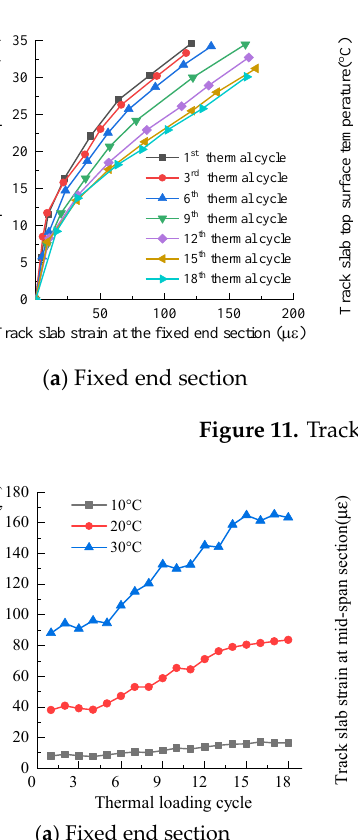
Thermal loading cycles Figure 10. Curve of the gap length varying with the cycles of temperature loading action. During the 18th thermal loading cycle, the gap only appears in the track slab near the fixed end with the shear slot along the longitudinal direction of the bridge. There is no gap at the sliding end of the beam far away from the shear slots. This shows that the restraint of the shear slots on the free deformation of the track structure is one of the important causes of the interlayer gap initiation under the action of thermal loading. Due to the influence of construction technology, the bond strength of the interlayer interface between the CA mortar and the track bed is far greater than that of the interlayer interface between the CA mortar and the track slab. Therefore, the interface gap mainly occurs between the CA mortar and the track slab. The interface between the CA mortar and the track bed remains intact, and no gap was observed. 3.3. Strain Results under Thermal Load 3.3.1. Track Slab Strain From the processing of the data collected by the fiber grating strain gauges, the variation law of the track slab temperature–strain curve with the number of thermal loading cycle was obtained, as shown in Figure 11. It can be seen from Figure 11a,b that at the fixed end section (with shear slots) and at the mid-span section, the temperature–strain plot of the track slab follows the increase of the thermal loading cycle and gradually shifts toward the strain increase direction. The distribution of